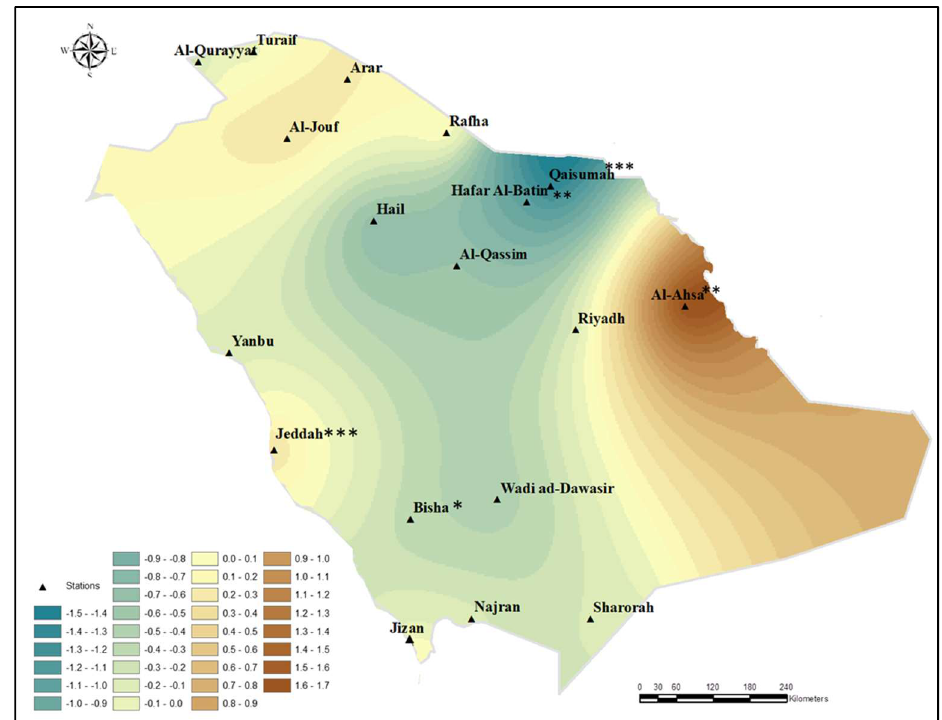
Figure 6. Annual change in dust storm frequency (number of events/year) over Saudi Arabia. Increasing trends are shown in brown, while decreasing trends are shown in blue (Table 1).